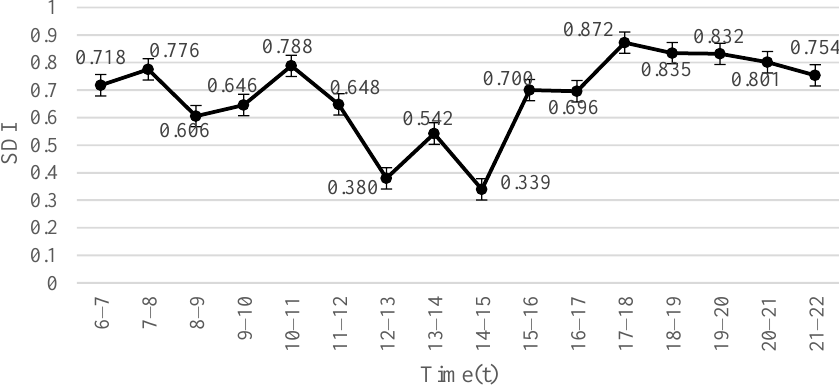
Figure 8. Characteristics of daily variation of the SDI.